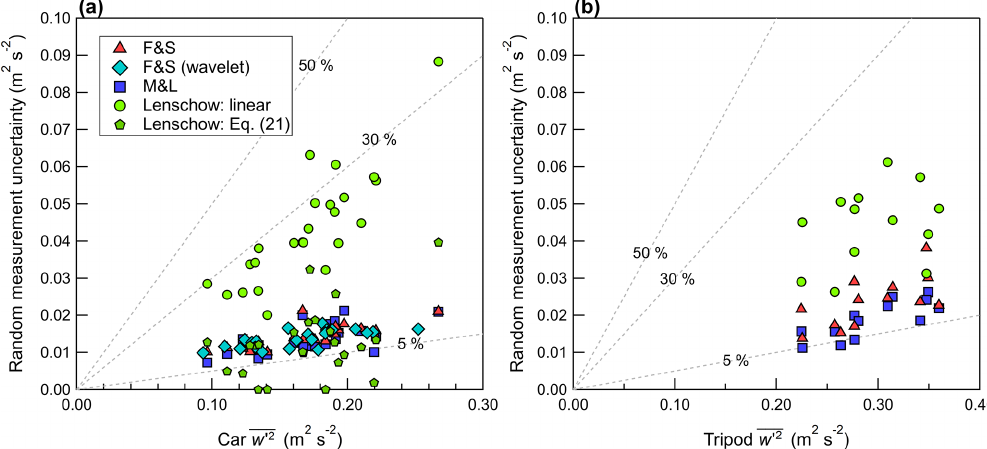
Figure 12. Random measurement uncertainty of the vertical velocity variance measured (a) on the car and (b) on the tripod, plotted as a function of w (cid:48) 2 . Dashed gray lines denote constant percentages of the independent